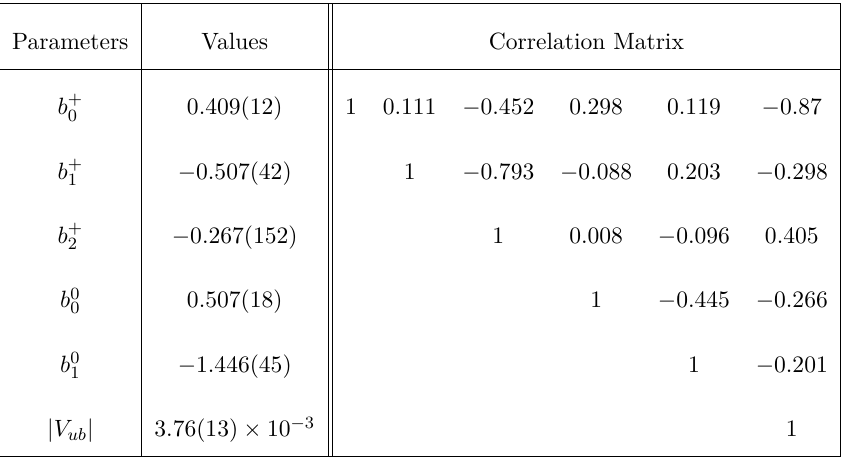
Table 5 . Theory predictions for the B → π‘ ¯ ν ‘ form-factor shape parameters and the CKM matrix element | V (with their correlation matrix) from carrying out the simultaneous fit against the ub | SCET sum rules, lattice QCD and experimental data points with the aid of the truncated BCL z -parameterizations at N = 3